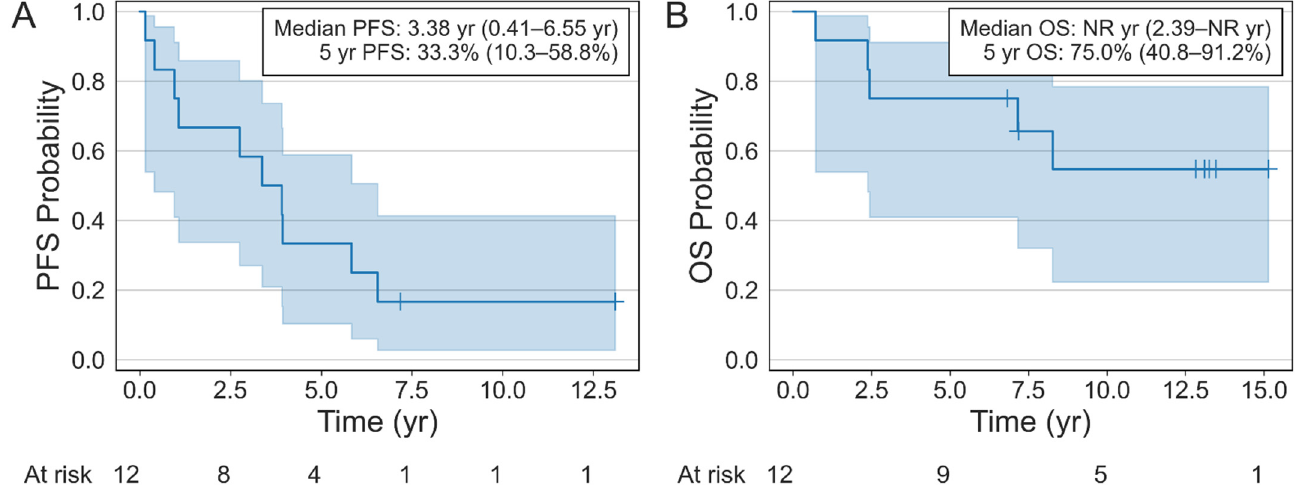
Figure 1. Kaplan–Meier Survival Curves Depicting PFS ( A ) and OS ( B ). Full patient-level information is detailed in Table 2. All patients who did not com- plete the tandem transplant are deceased. Two patients remained in remission at 13.1 and 7.2 years. One patient had ER+/PR − /HER2-disease with radiation to a single thoracic spine